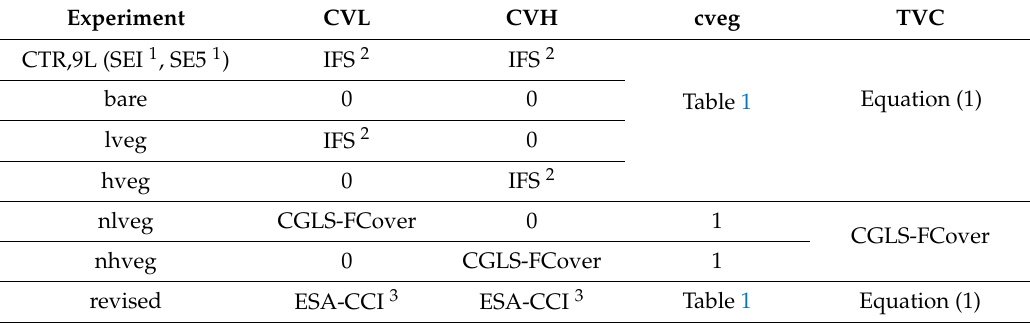
Table 2. Simulations setup configuration for each experiment denoting the used low vegetation grid fraction (CVL), the high vegetation grid fraction (CVH), the vegetation density (cveg) and the total vegetation cover (TVC).